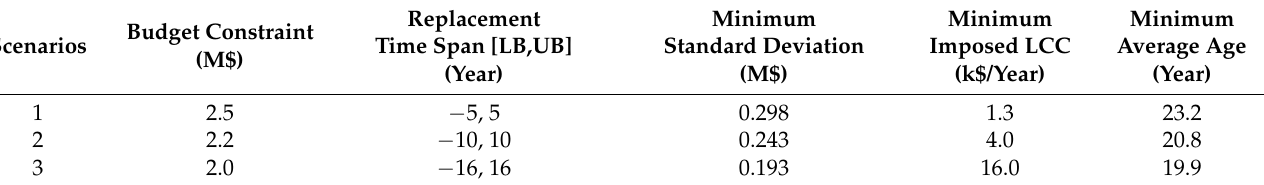
Table 7. Comparison of three evaluated